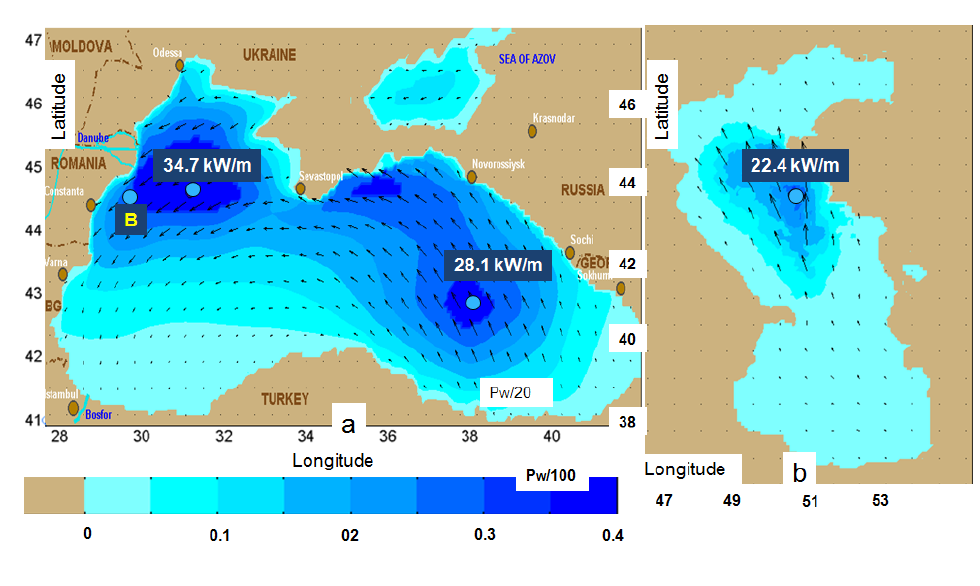
Figure 4. ( a ) Distribution of the mean relative wave power in the Black Sea (SWAN simulation corresponding to the time frame 1997/01/18/h12, average energetic conditions) and the position of the reference point (B-point); ( b ) Distribution of the mean relative wave power in the Caspian Sea (SWAN simulation corresponding to the time frame 2009/10/02/h18, winter average energy